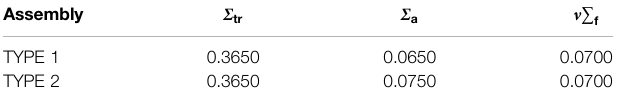
TABLE 2 | Cross-section (XS) for the one-group reactor problem. Assembly